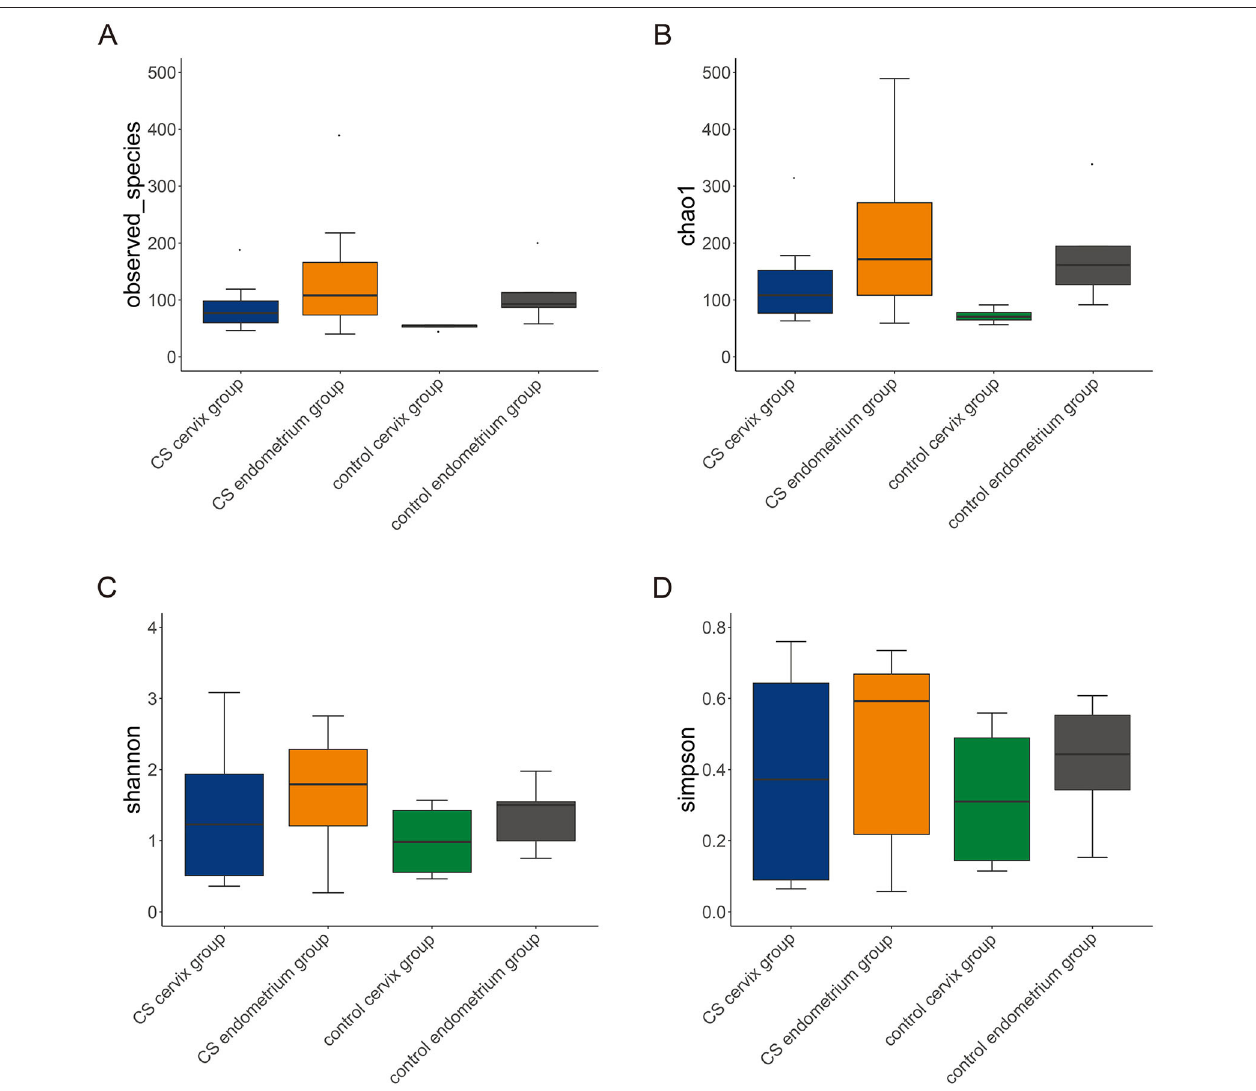
FIGURE 1 | Alpha diversity. The alpha diversity, including observed species index (A) , Chao index (B) , Shannon index (C) , and Simpson’s diversity index (D) . The cesarean section group had a higher number of microbial species and greater diversity, when compared to the control group. In particular, there was a higher diversity index in the endometrium, when compared to cervix tissues, in each